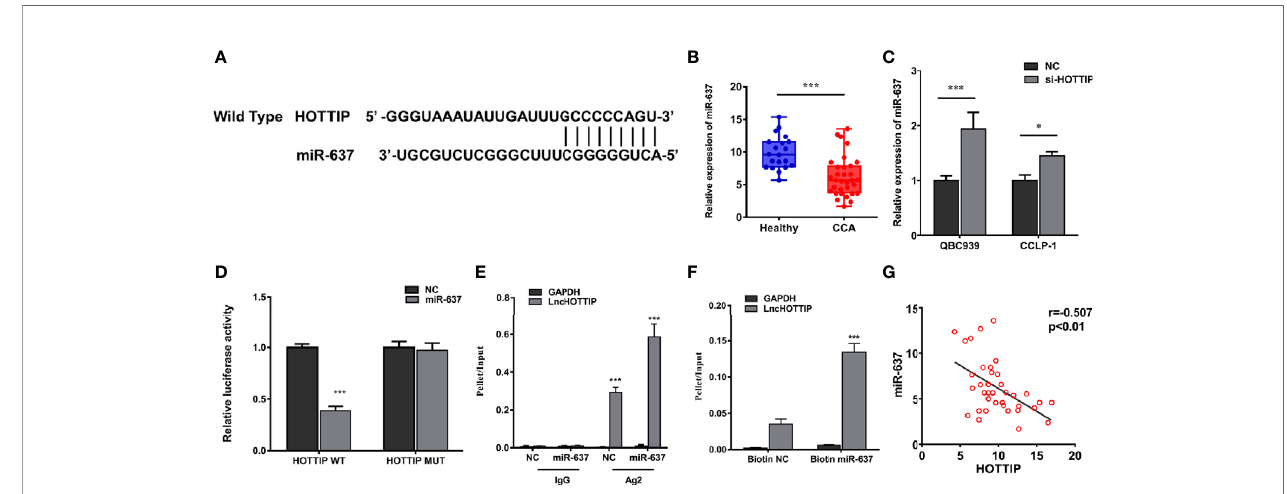
FIGURE 3 | HOTTIP could bind to miR-637. (A) Predictive binding sites of lncRNA HOTTIP with miR-637. (B) The relative miR-637 expression levels of healthy volunteers and CCA patients. (C) The miR-637 expression level of HOTTIP inhibition in QBC939 and CCLP-1 cells. (D) Luciferase reporter gene assay of HOTTIP and miR-637. (E) The Anti-AGO2 immunoprecipitation (RIP) assay. The relative pellet/input ratios were calculated. (F) The pull-down assay of miR-637 and HOTTIP. (G) Correlation between HOTTIP and miR-637 in CCA patients. (*p < 0.05, ***p <